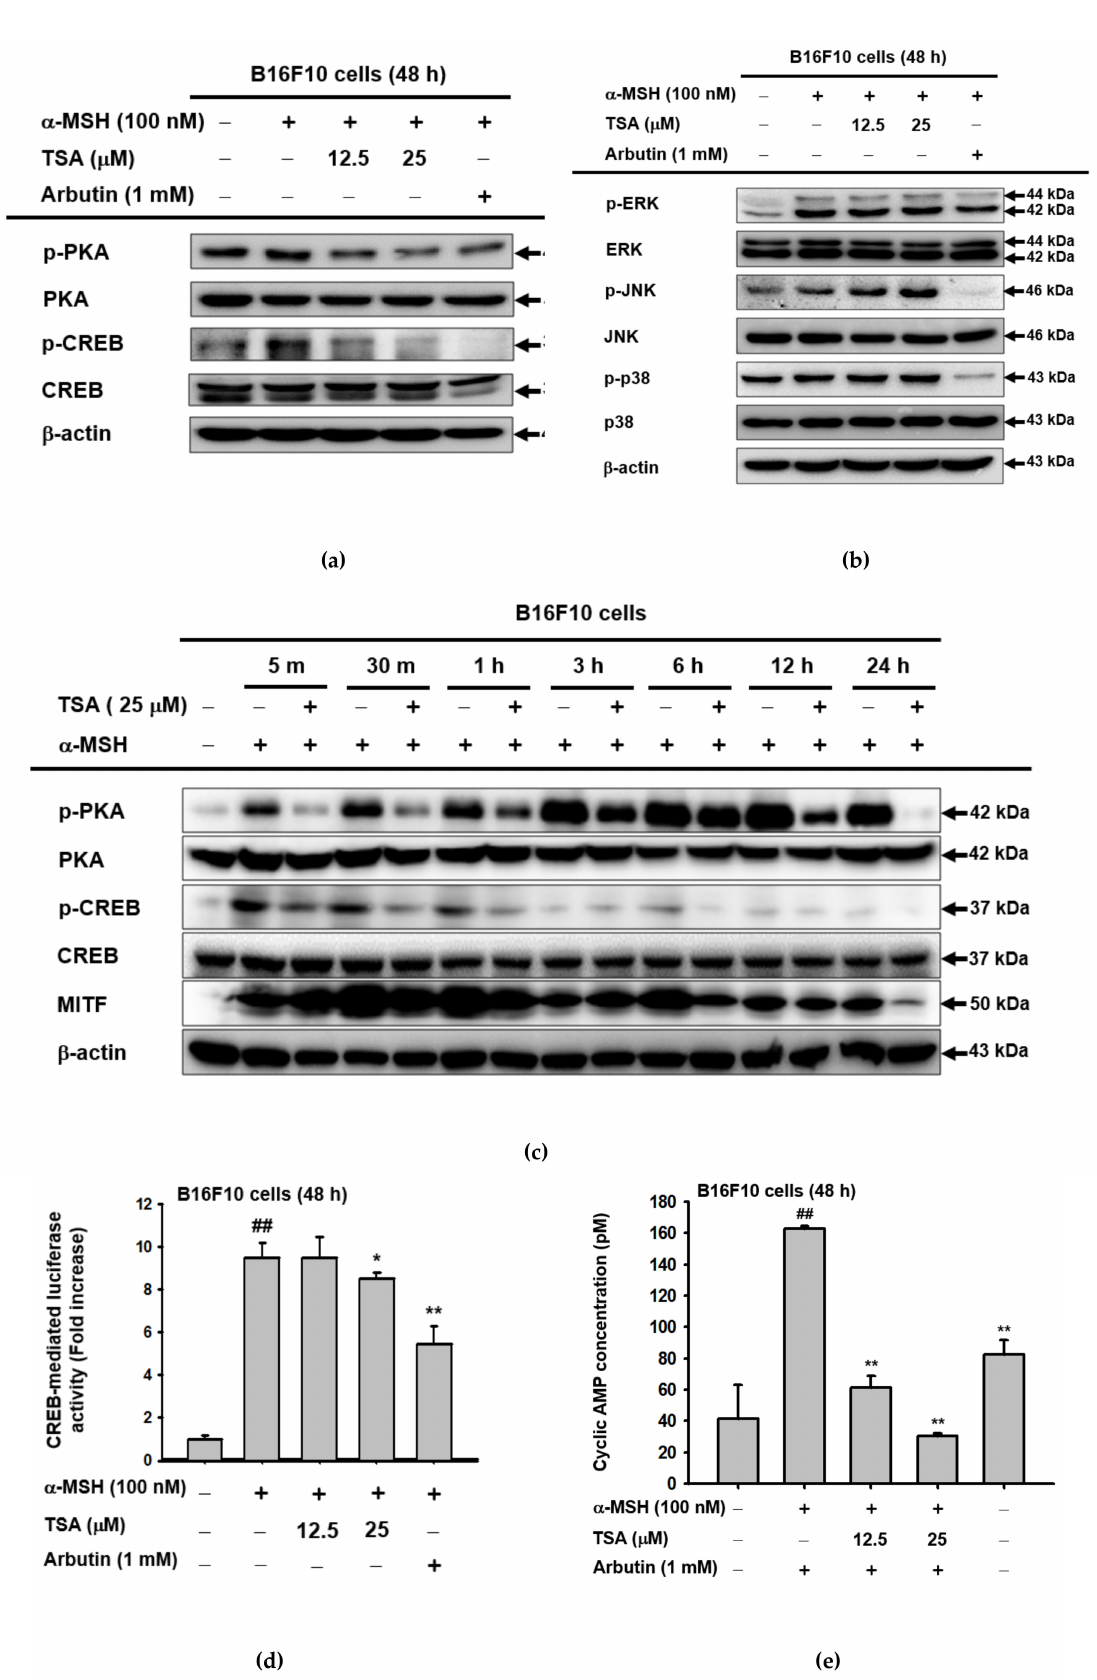
Figure 4. Regulation of the cAMP/CREB signaling pathway of TSA in B16F10 cells. ( a – c ) Protein levels of various